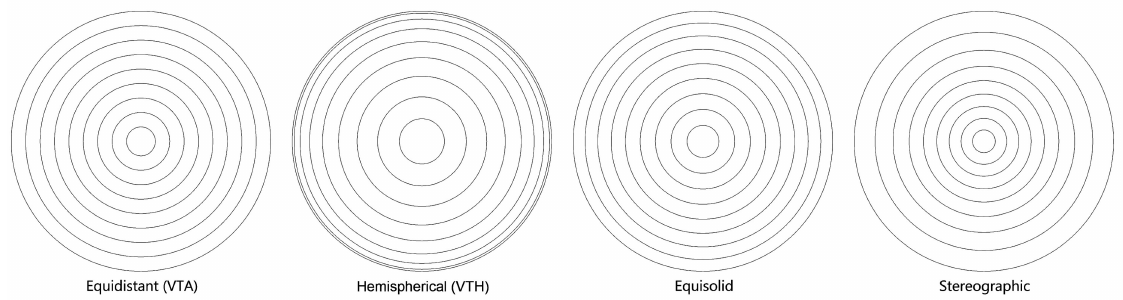
Figure 1. The four commonly used methods for projecting fisheye images.